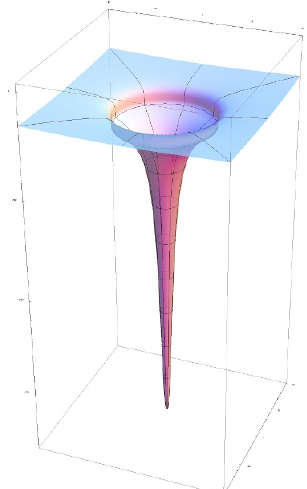
Figure 11 . Schematic 3D picture for the case of (cid:12)gure 10. The radius r corresponds to that in the horizontal direction while the vertical axis is chosen such that the distance along the 2D surface in the picture is given by the change in the r (cid:3)